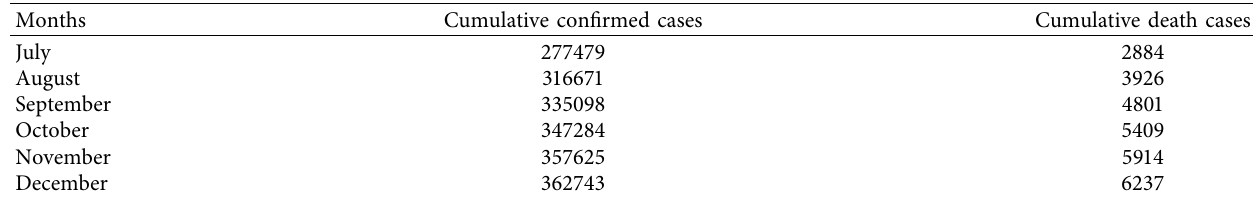
Table 4: Monthly number of COVID-19 cases in Saudi Arabia from July to December